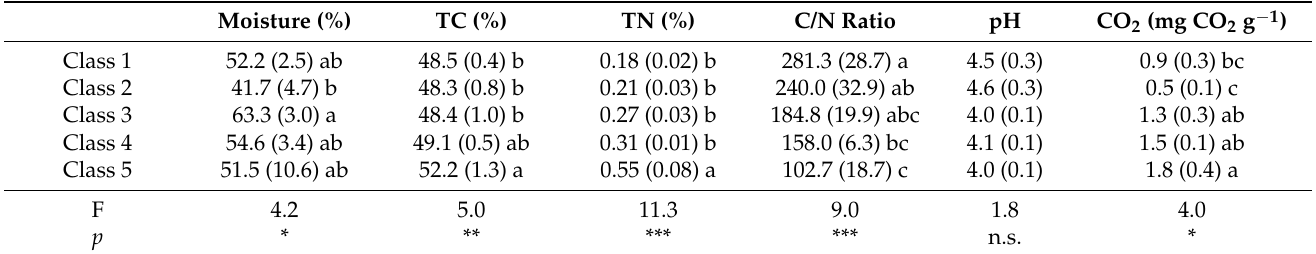
Table 1. Moisture, total C (TC) and total N (TN) contents, C/N ratio, and pH of the black pine deadwood cores collected from the different decay classes in Pratomagno study area calculated as the percentage of the total dry mass of deadwood. Maximum values of CO 2 production by deadwood cores under closed laboratory systems are also reported [20]. Standard errors are in parentheses. Different letters in a column indicate significant differences at p < 0.05 (Tuckey test) among